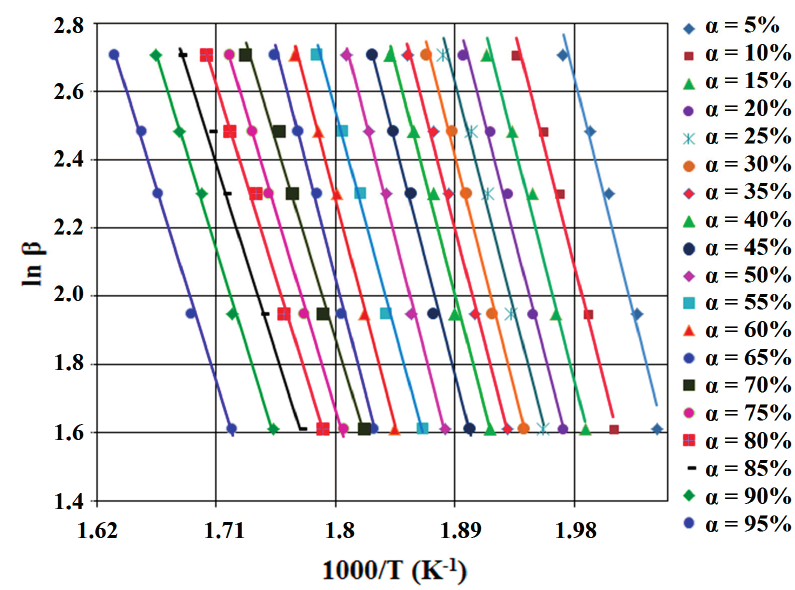
Figure 5. FWO diagram, for SB2